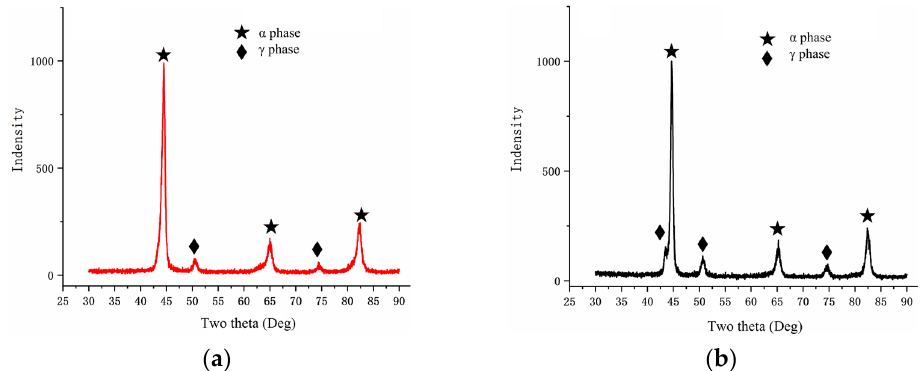
Figure 4. The XRD profiles of ( a ) laser-polished and ( b ) laser-annealed specimens.